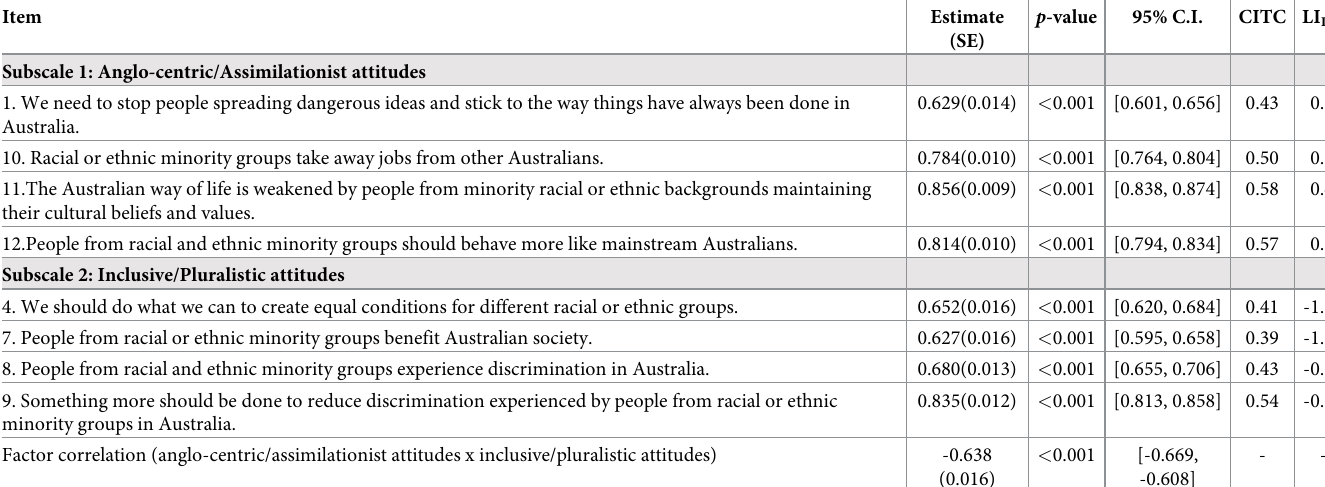
Table 3. Confirmatory Factor Analysis: Factor loadings ( λ s) and factor correlations (n = 2,443). Item